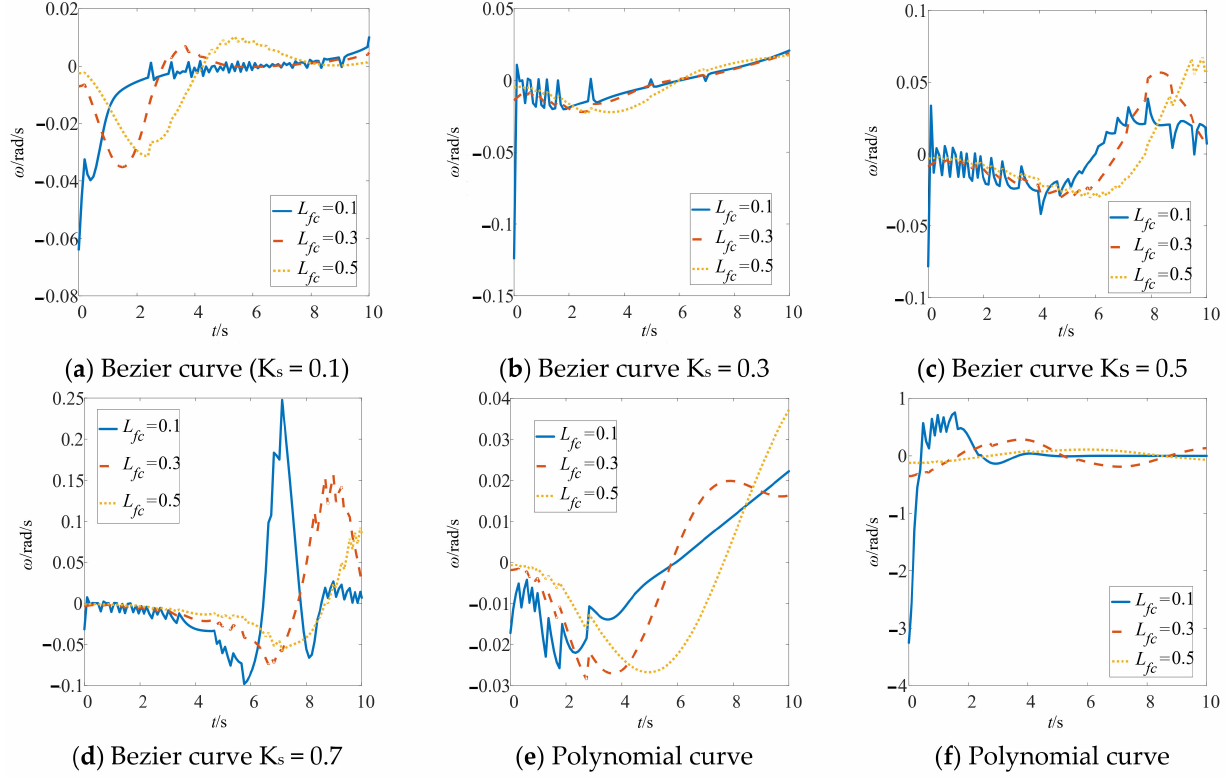
Figure 13. An angular velocity comparison under different planning paths and lookahead distances.